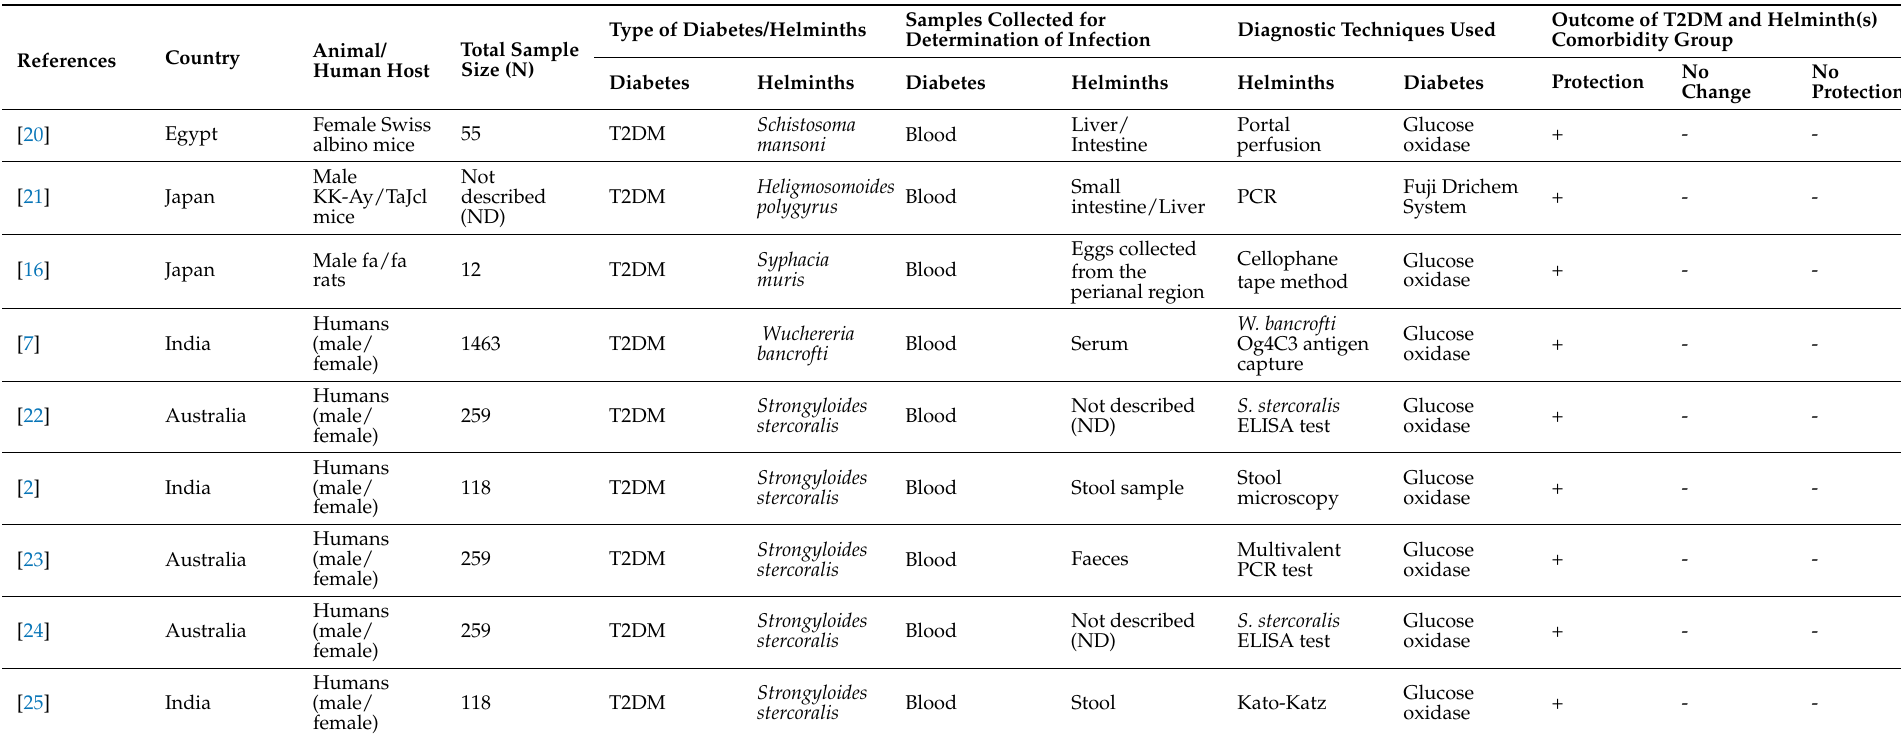
Table 3. Summary of the diagnostic techniques used in the helminth/type 2 diabetes mellitus comorbidity studies included in the